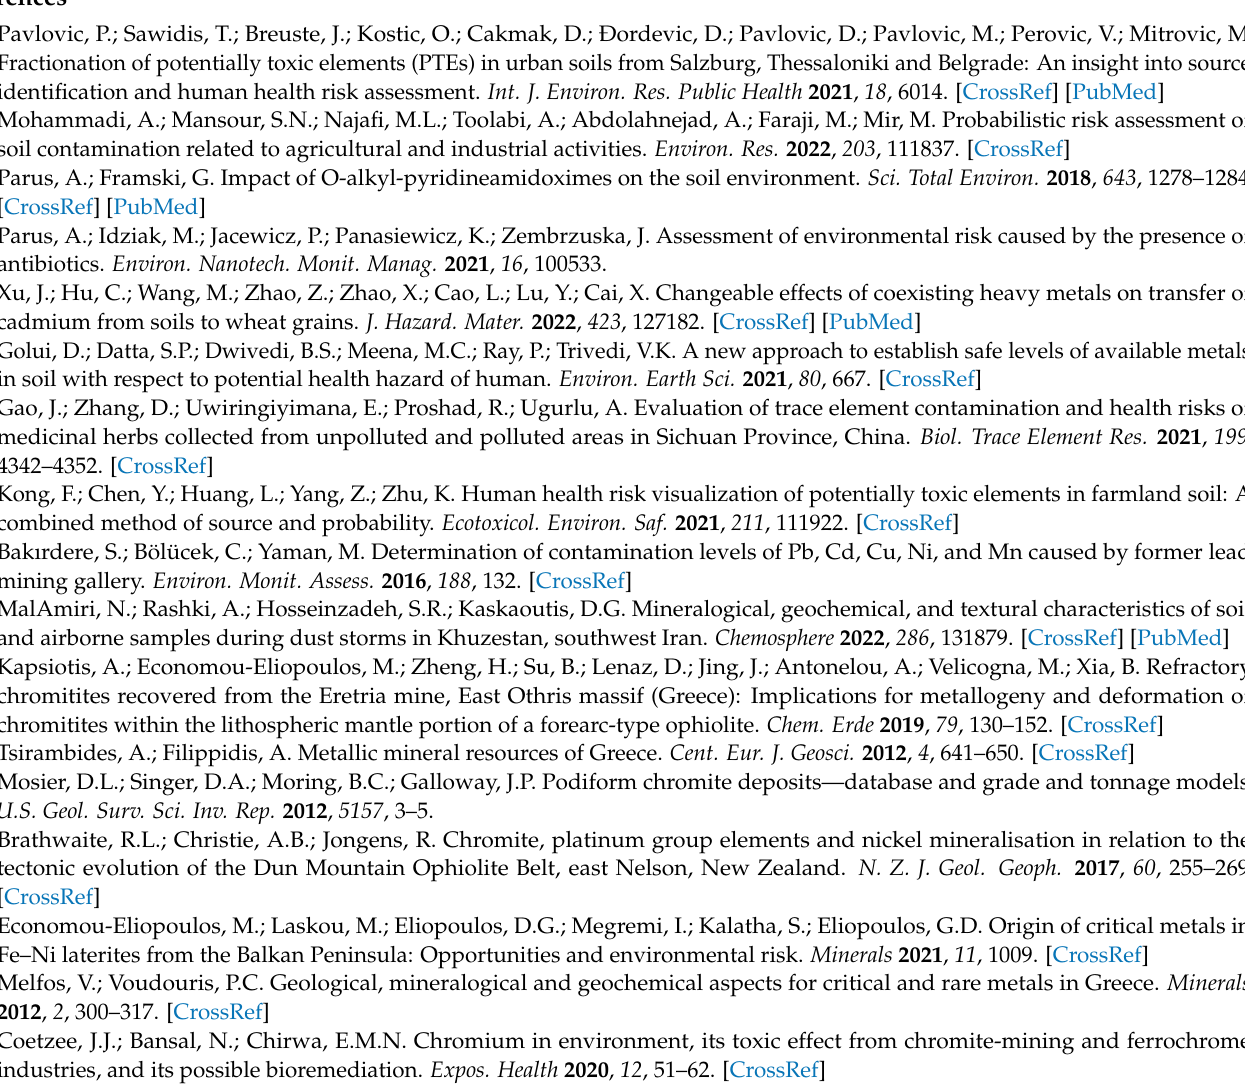
Table S19: Duncan tests for HQ soil ingestion in the three studied areas: adults (a), children (b), Table S20: Duncan tests for Eretria HQ (soil ingestion) adults (a) and children (b), Domokos HQ adults (c) and children (d) and steel factory (Volos) HQ adults (e) and children (f), Table S21: Hazard Index (HI) for soil ingestion in the three studied areas, Table S22: Hazard Index for humans from wheat grain